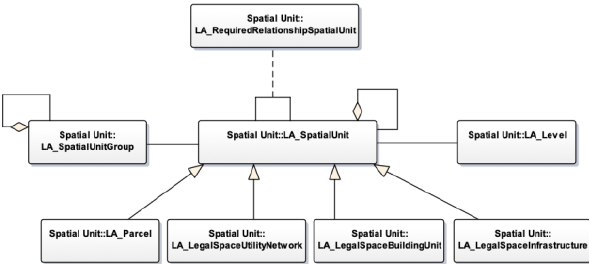
Figure 3 . Classes of Spatial Unit Package of LADM Edition II - Part 2 Land Registration (Lemmet et al., 2021)